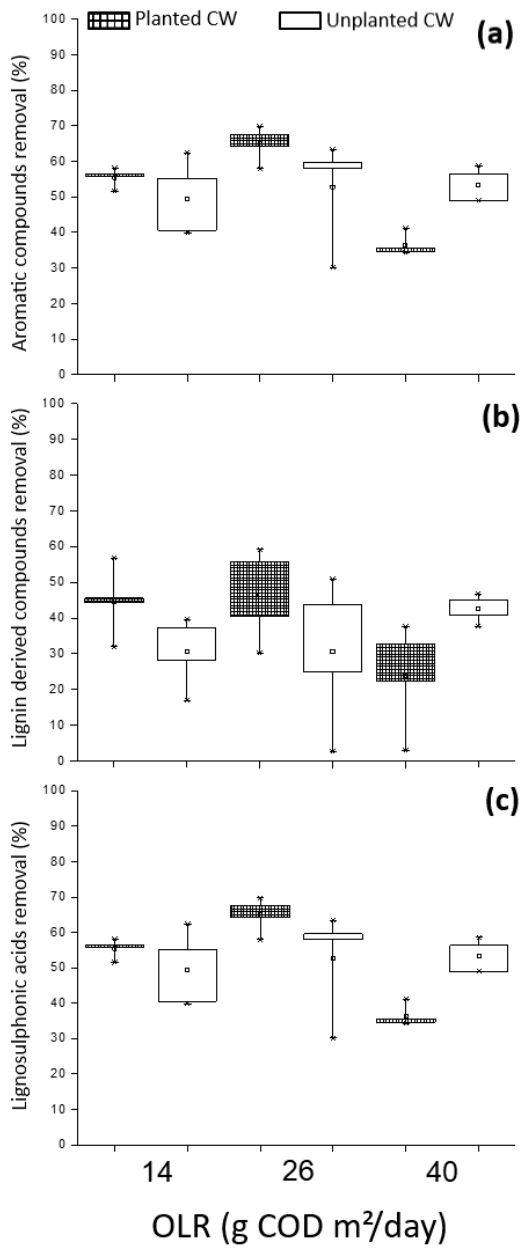
Figure 4. Removal efficiency of ( a ) aromatic compounds; ( b ) lignin-derived compounds; and ( c ) lignosulphonic acids contained in E. globulus leachates treated in the planted and unplanted CW.